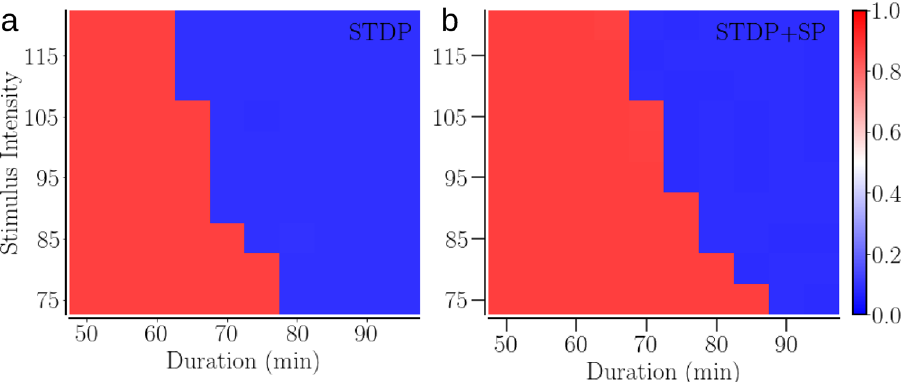
Figure 12. The efficiency of RVS CR stimulation in inducing long-term desynchronization in an initially synchronized network of identical oscillators in the two plasticity schemes—STDP ( a ) and STDP + SP ( b ). Colors indicate the order parameter 100 h after the cessation of stimulation for a given pair of stimulus intensity and duration. The red indicates synchrony and the blue desynchrony. Parameters are a = 0.3 , γ = 3 , and F s = 10 Hz.